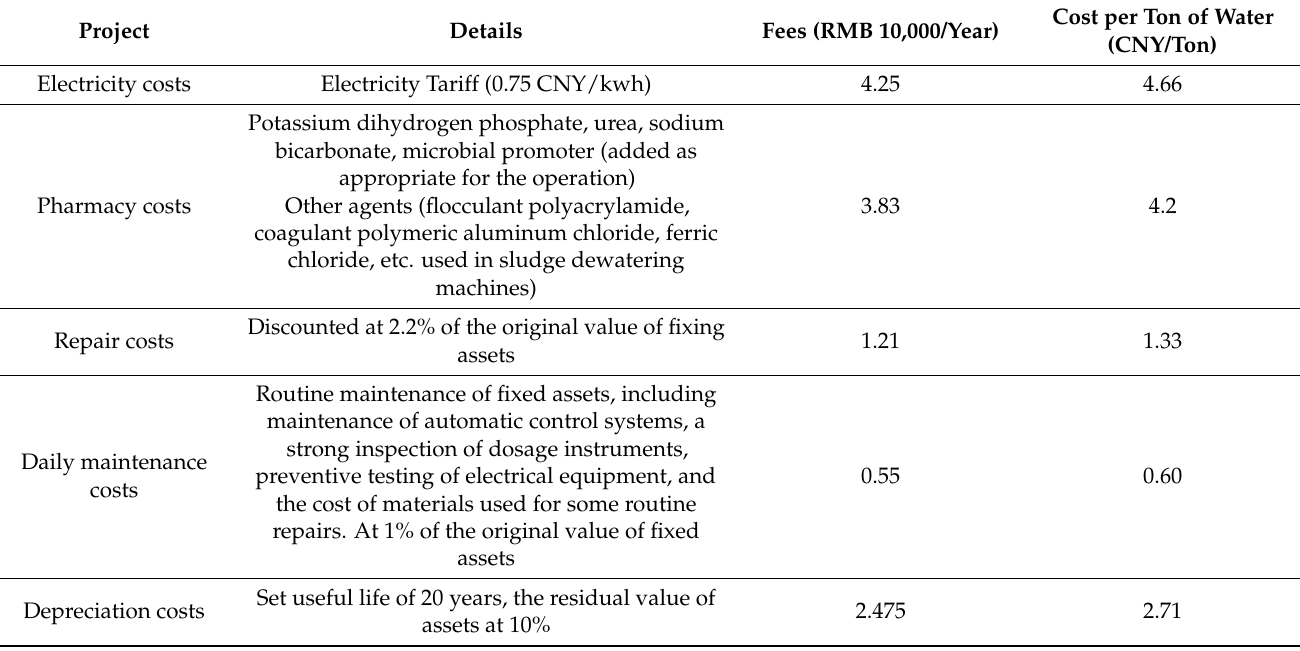
Table 4. Operating